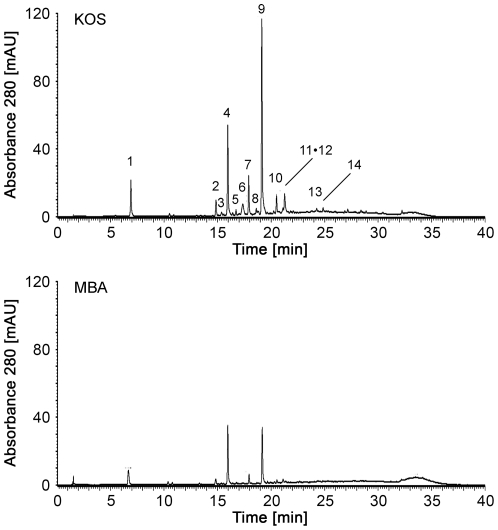
Typical liquid chromatography profile of Koshu and MBA grape seed extracts.Polyphenols in the eluate were detected by absorbance at 280 nm. The peaks were assigned by TOF-MS as shown in Table 1.